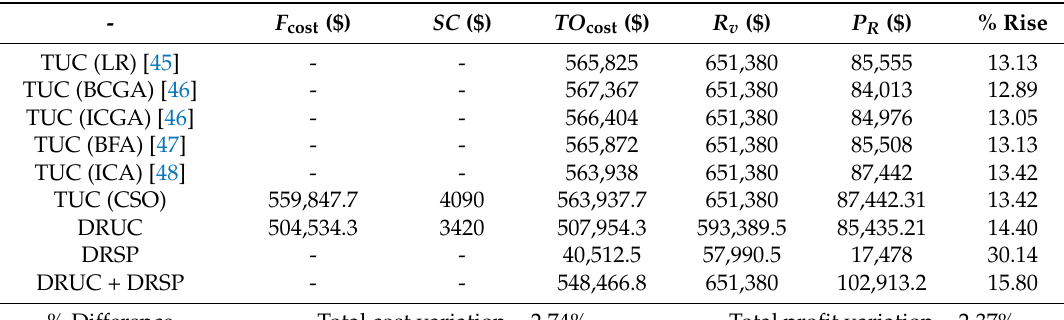
Table 9. Various data